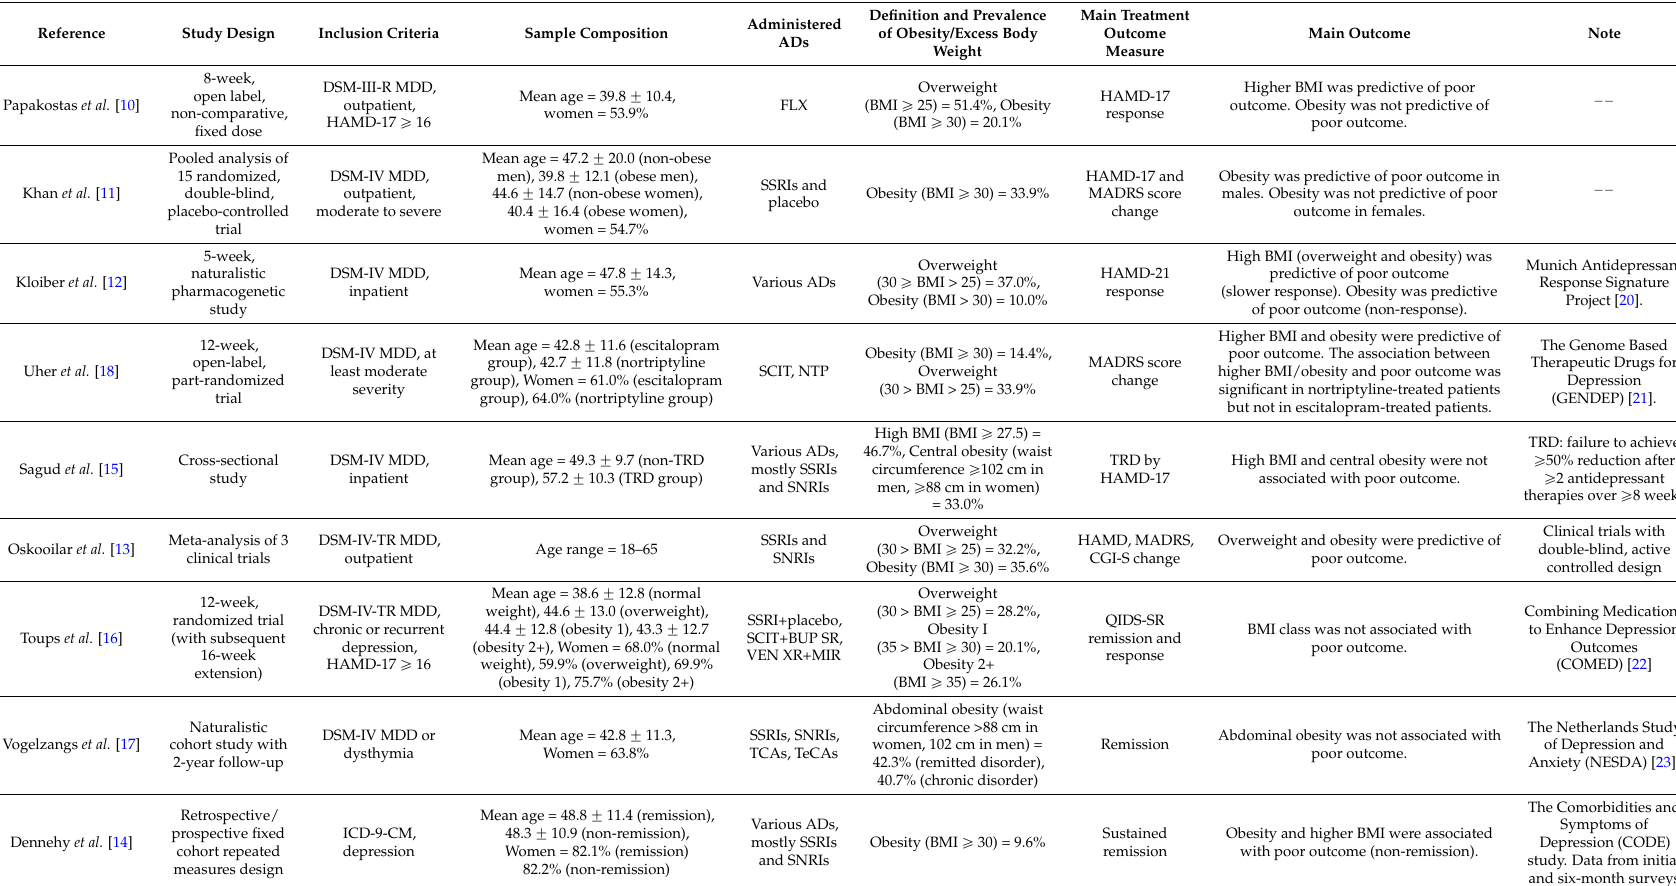
Table 1. Characteristics of prior studies investigating the associations between depressive disorders, obesity/excess body weight, and antidepressant responses. Reference